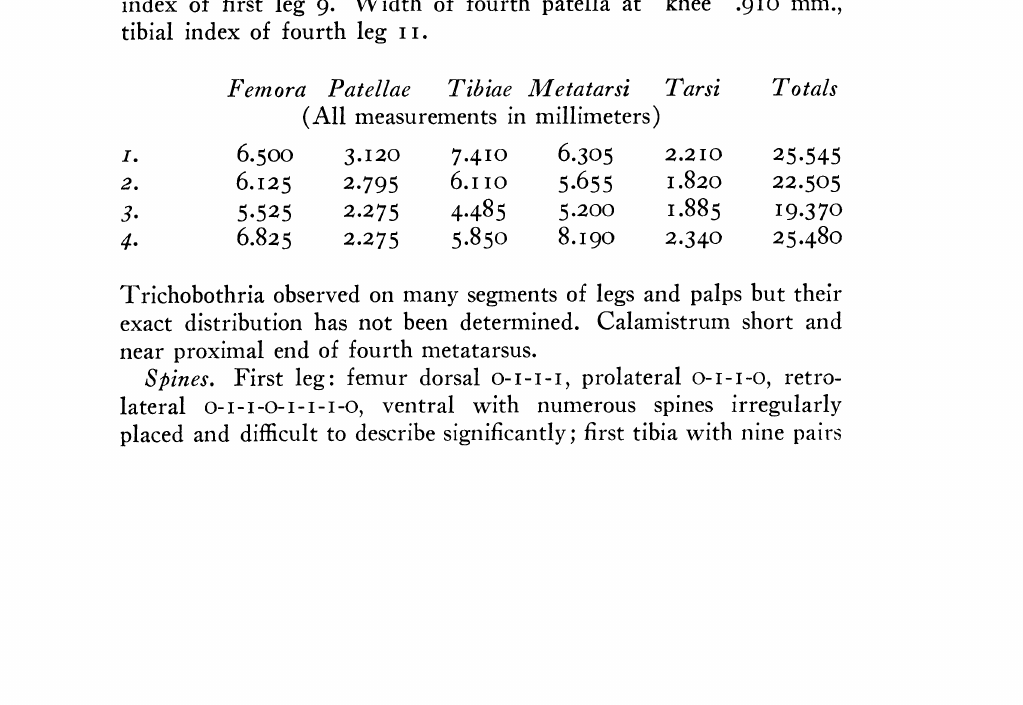
Tarsi Totals Femora Patellae